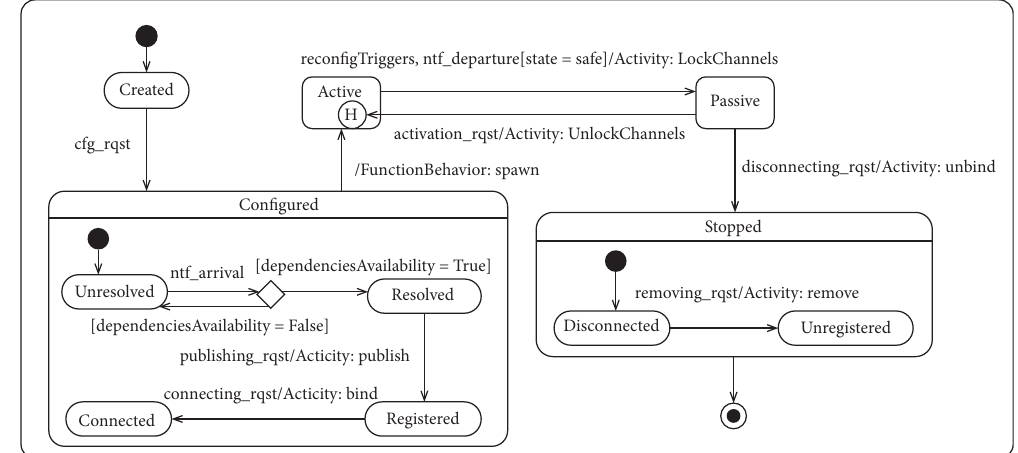
Figure 6: Component instance life cycle.